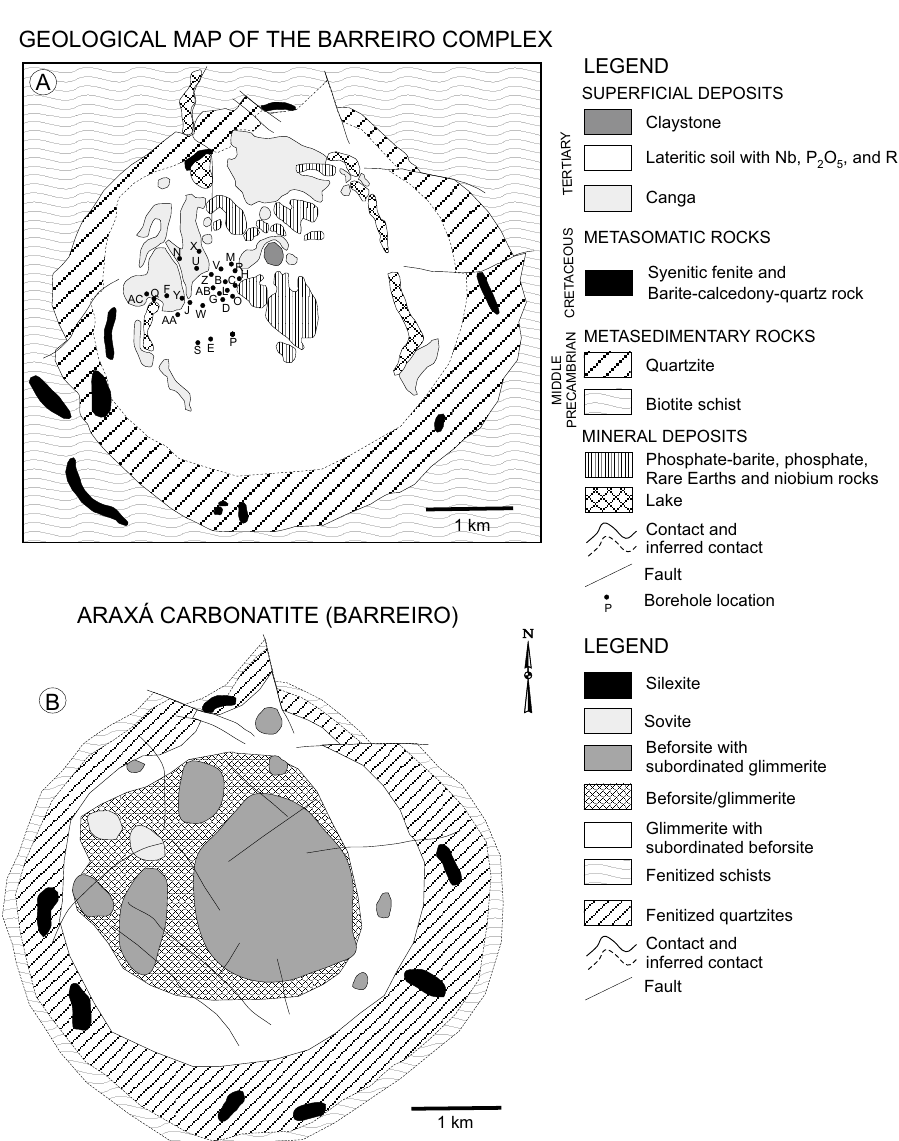
Fig. 2 – Schematic interpretation of theAraxá carbonatite geology (after Issa Filho et al. 1984) (A) and surface geological map (after Grossi-Sad & Torres 1976 simplified) (B). Also shown is the bore-holes